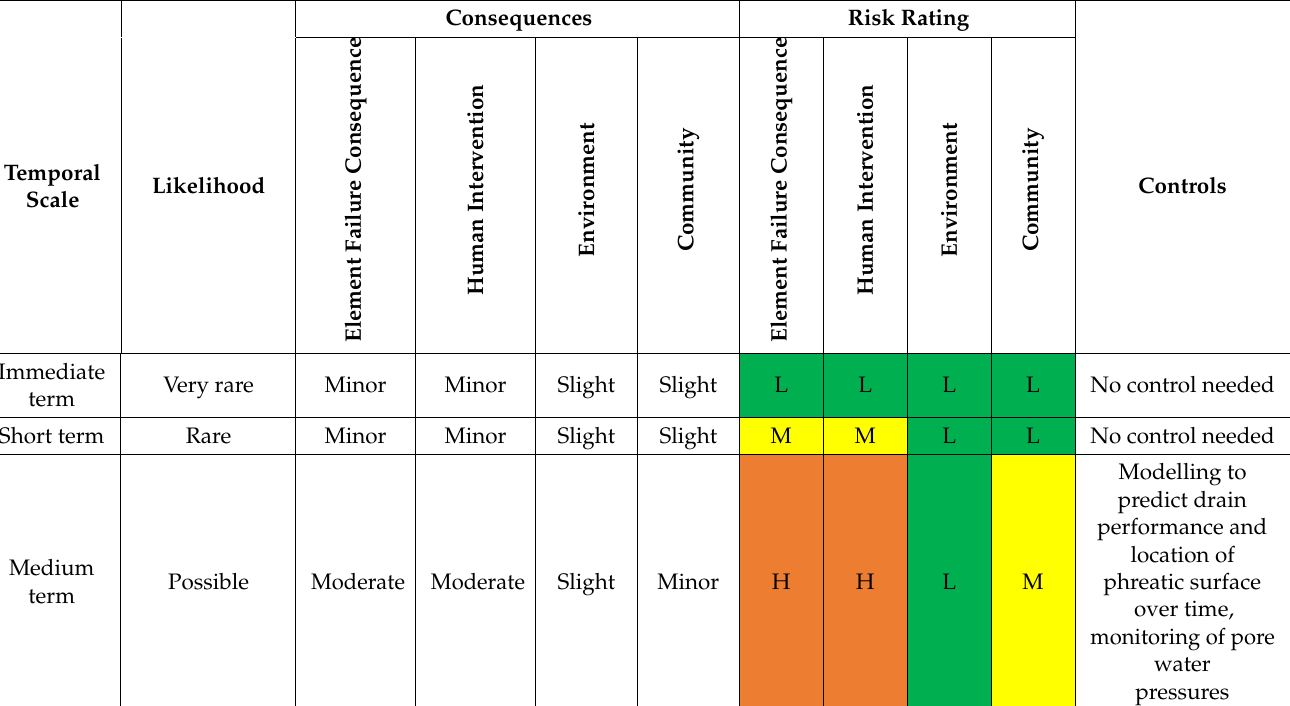
Table 6. Immediate-term, short-term, and medium-term risk assessments for particulate clogging of level 2